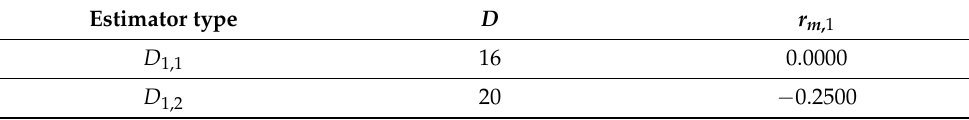
Table 1. Coefficients for Considered Values of D for K = 1.